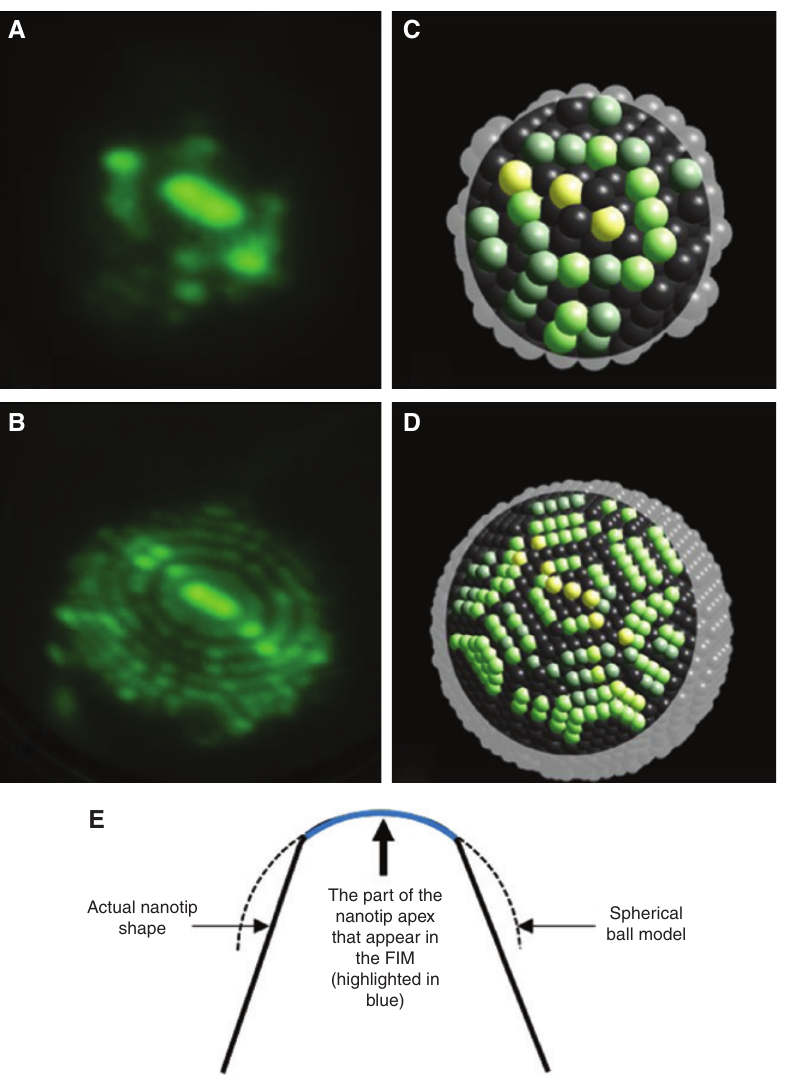
Figure 4: FIM images for (A) a nanotip with a radius of 1.18 nm and (B) a nanotip with a radius of 3.02 nm. Ball model representation for (C) the nanotip in A and (D) the nanotip in B. (E) A schematic showing the lateral view of a nanotip.